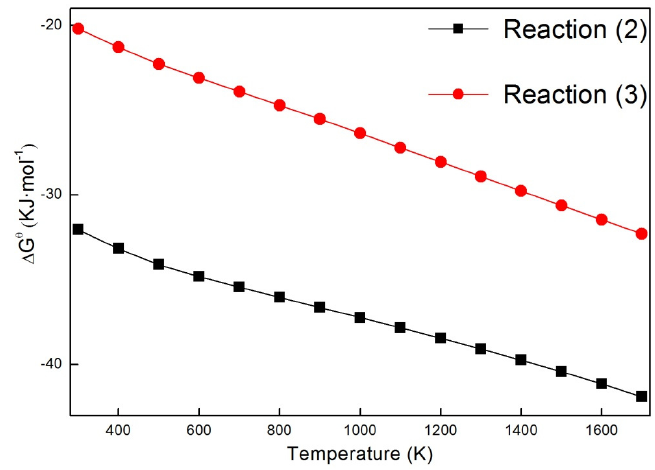
Figure 3. Gibbs free energy change ( △ G ) for Reactions (2) and (3).